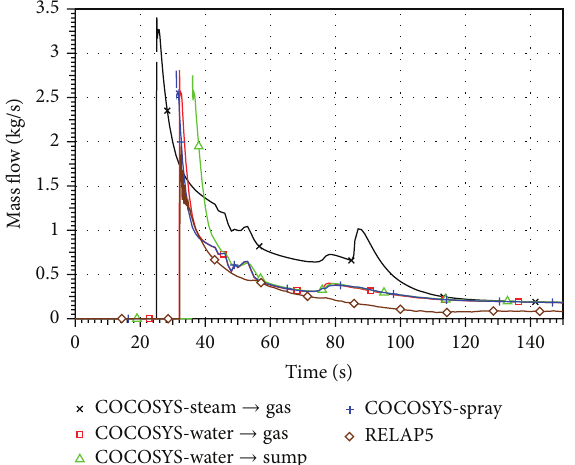
Figure 7: Coolant release options: flow rate through the burst disk. Figure 8: Coolant release options: water mass in PV.